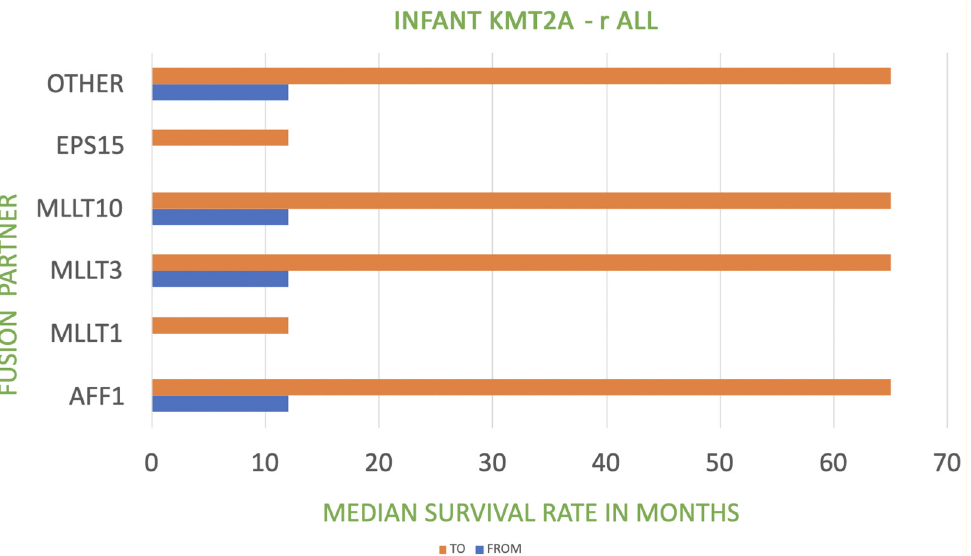
Figure 1. Relationship between KMT2A fusion partner and median survival rate in infant KMT2A - r ALL.